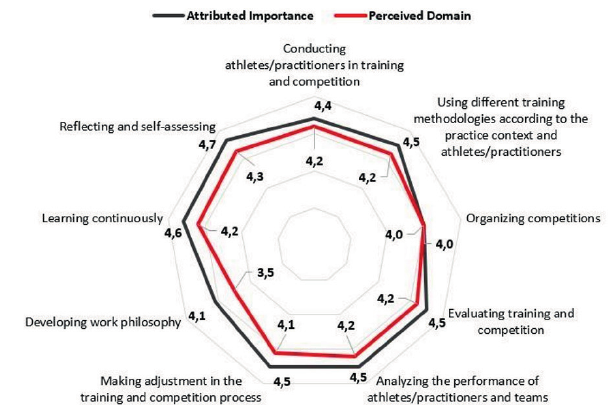
Figure 2. Attributed importance and perceived domain about the competences of racket sports coaches (part 1).